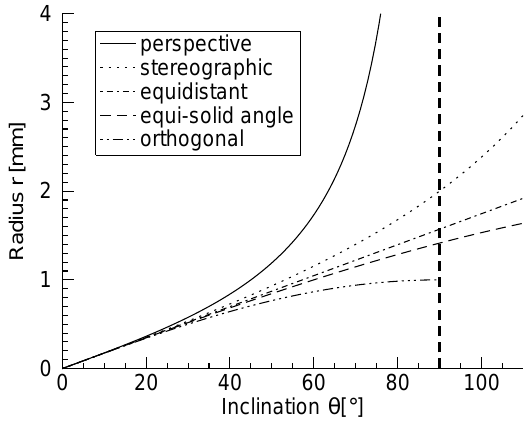
Figure 3: Trigonometric camera models